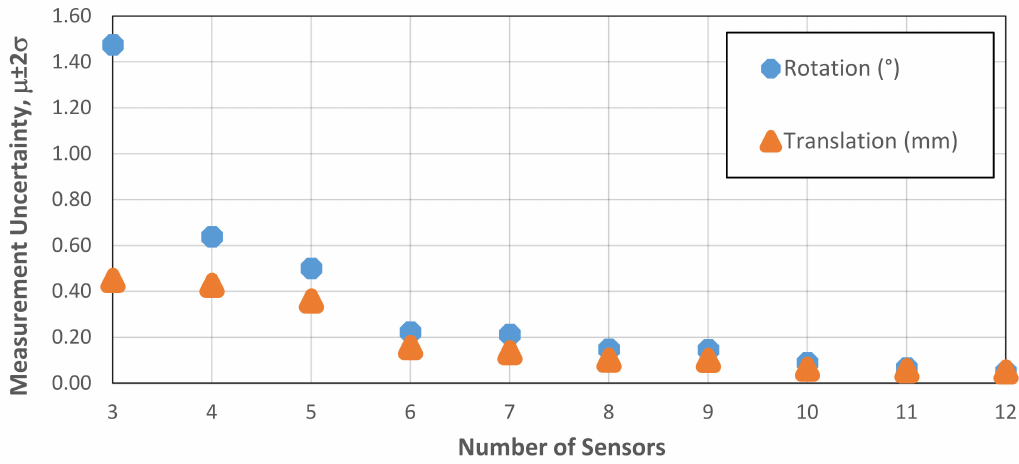
Figure 11. Effect of the number of sensors on the measurement uncertainty in translation and